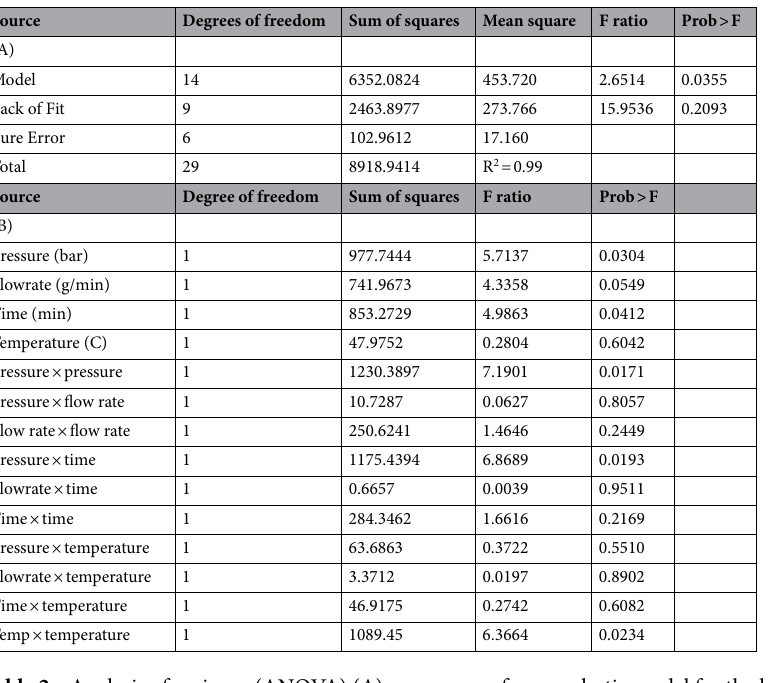
Table 2. Analysis of variance (ANOVA) (A) response surface quadratic model for the lycopene yield from grapefruit and (B) Independent variables and their interactions for lycopene yield from